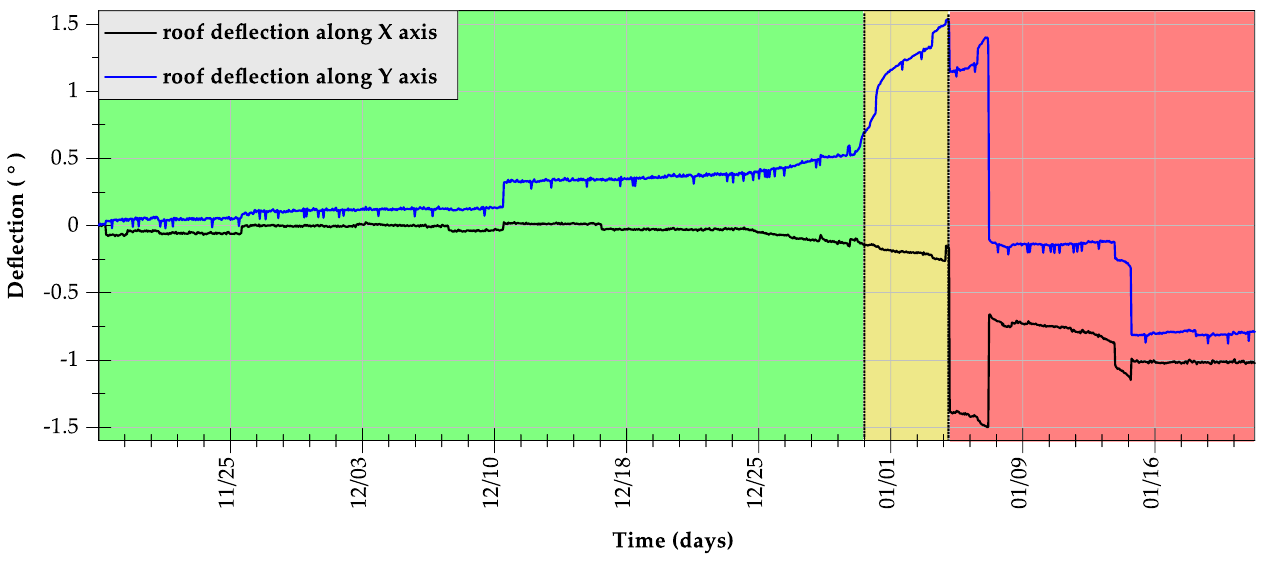
Figure 12. An exemplary case of ground failure prediction with the use of an inclinometric sensor.